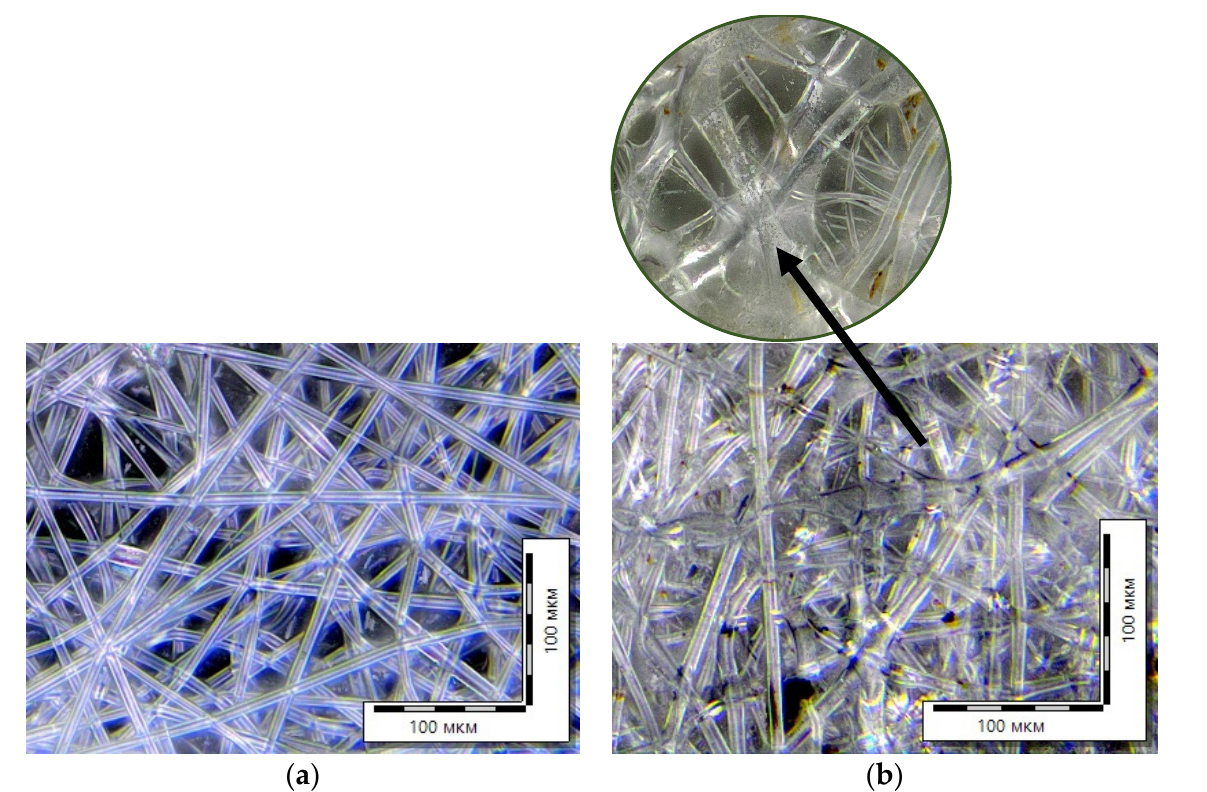
Figure 8. Optical micrographs of nonwoven samples: initial PLA ( a ) and PLA substrate ( b ).